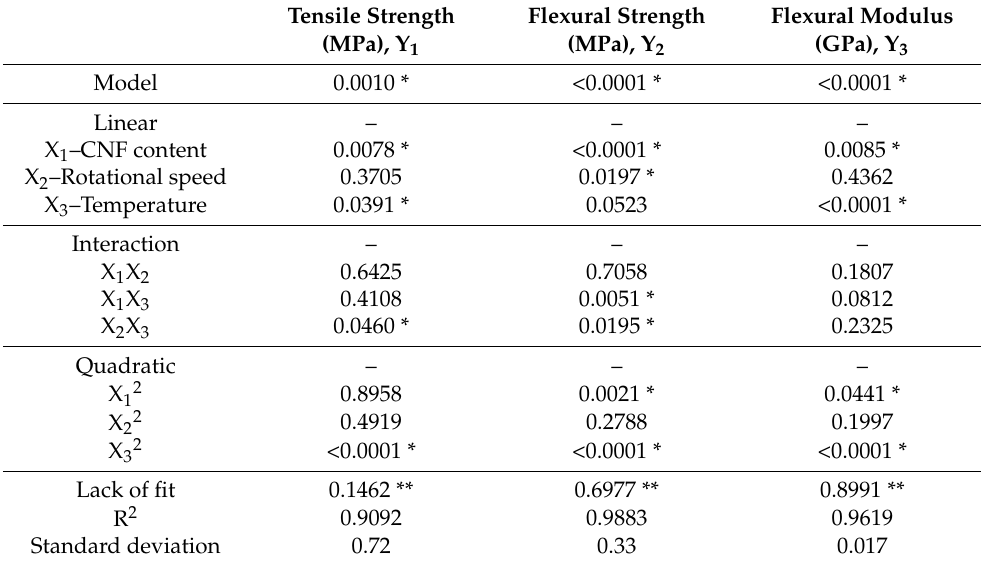
Table 3. Analysis of variance (ANOVA) for response surface quadratic model. Tensile